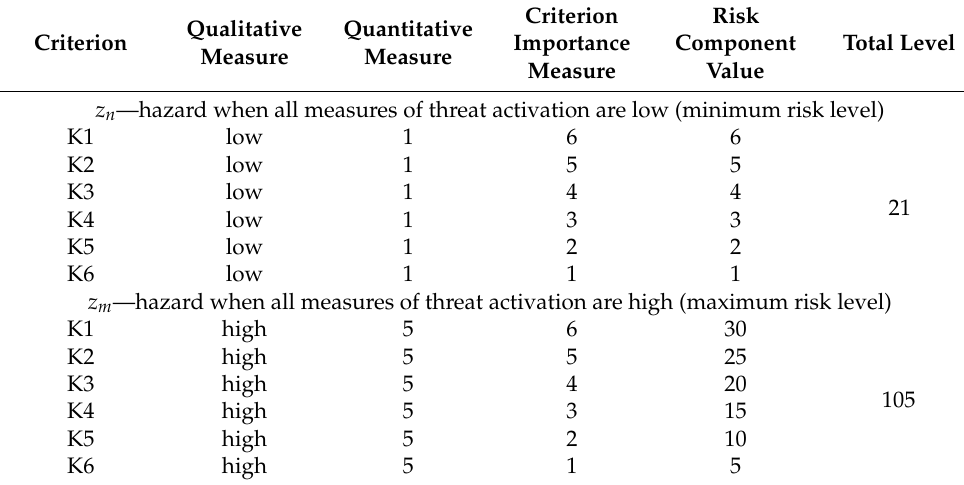
Table 2. Classification of risk acceptability in UAV operations.